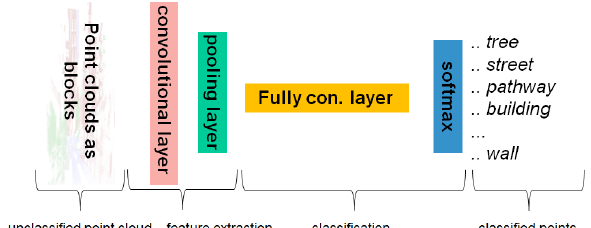
Figure 2. Structure of ConvNet for semantic point cloud